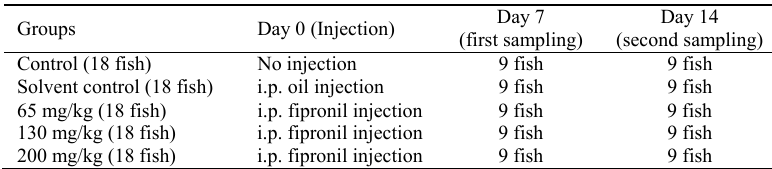
Table 2. Experimental design for fish exposure to fipronil and tissue sampling. Groups